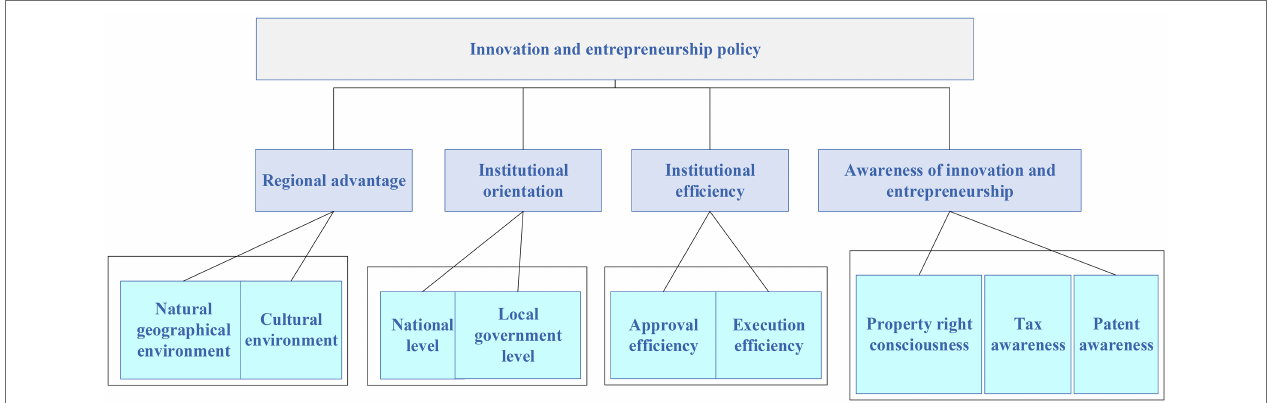
FIGURE 1 | Four indicators of innovation and entrepreneurship policy affecting economic